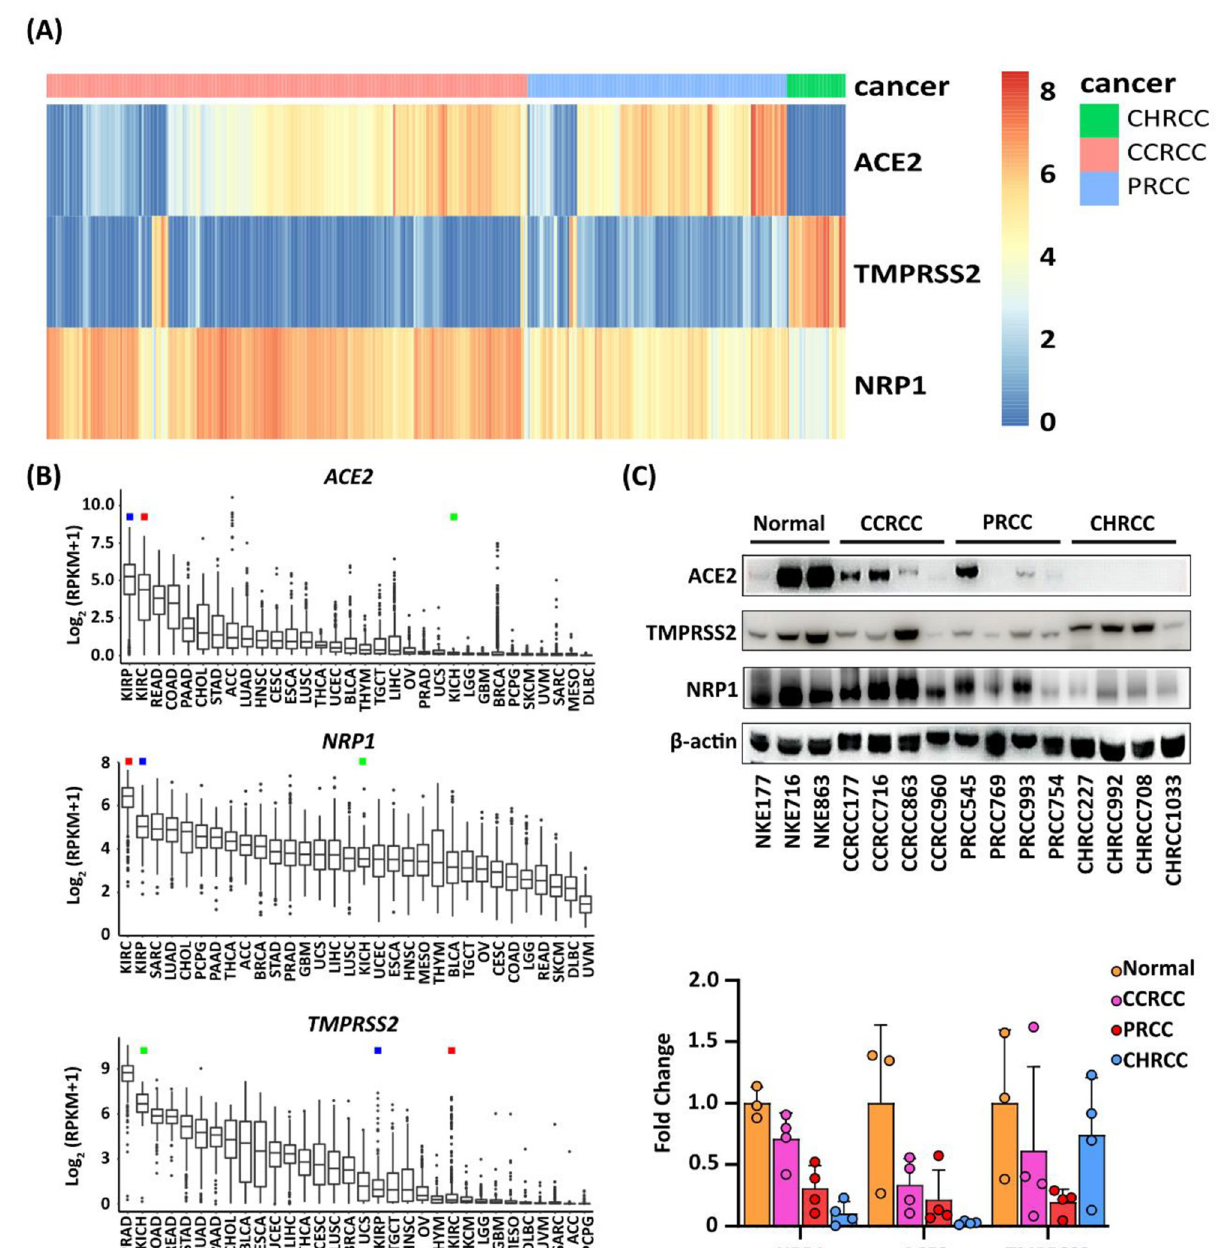
Fig 1. Expression of ACE2, TMPRSS2 and NRP1 in clear cell, papillary and chromophobe renal cell carcinoma and across 32 distinct cancer forms. (A) Bioinformatic analysis of the TCGA data sets for renal cell carcinoma showing mRNA expression levels for the ACE2 , TMPRSS2 and NRP1 genes in individual RCC cases for chromophobe renal cell carcinoma (CHRCC), clear cell renal cell carcinoma (CCRCC) and papillary renal cell carcinoma (PRCC). (B) Comparison of the mRNA expression levels for ACE2 , TMPRSS2 and NRP1 across 32 different types of malignancies deposited at the TCGA atlas. KIRC denotes CCRCC (red square), KIRP denotes PRCC (blue square) and KICH denotes CHRCC (green square). (C) Immunoblotting results for ACE2, TMPRSS2 and NRP1 proteins in lysates from normal tissue, CCRCC, PRCC and CHRCC. Results from densitometry of the protein bands is shown below the